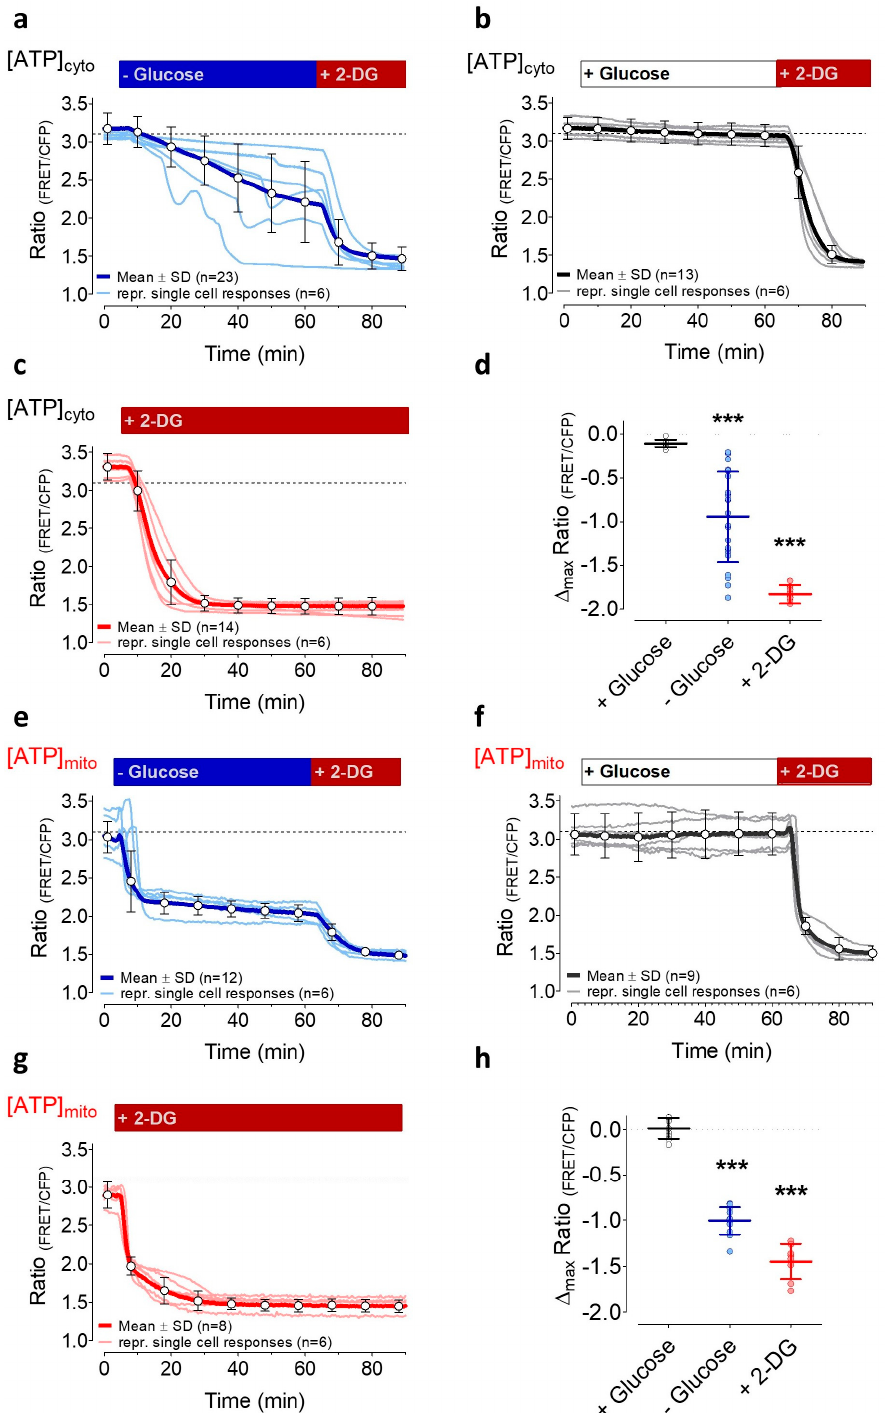
Figure 2. Cytosolic ( a – d ) and mitochondrial ATP ( e – h ) dynamics over time in response to energy stress. (a ) Representative curves (light blue) and the mean response ( ± SD, blue curve, n = 23 cells from three independent experiments) of FRET ratio changes of cytosolic AT1.03 in HeLa cells over time upon the removal of 10 mM glucose and the subsequent addition of 10 mM 2-deoxy-D-glucose (2-DG), as indicated; ( b ) Representative FRET ratio changes (grey) and mean curve ( ± SD, black curve, n = 13 cells from three independent experiments) of cytosolic AT1.03 in HeLa cells in the presence of 10 mM glucose and upon the addition of 10 mM 2-DG; ( c ) FRET ratio changes (light red) and mean curve ( ± SD, red curve, n = 14 cells from three independent experiments) of cytosolic AT1.03 in HeLa cells that were treated with 10 mM 2-DG; ( d ) Aligned dot plot with mean of maximal FRET ratio changes of AT1.03 between basal values and at time point 60 min. *** significant versus control (+ glucose);